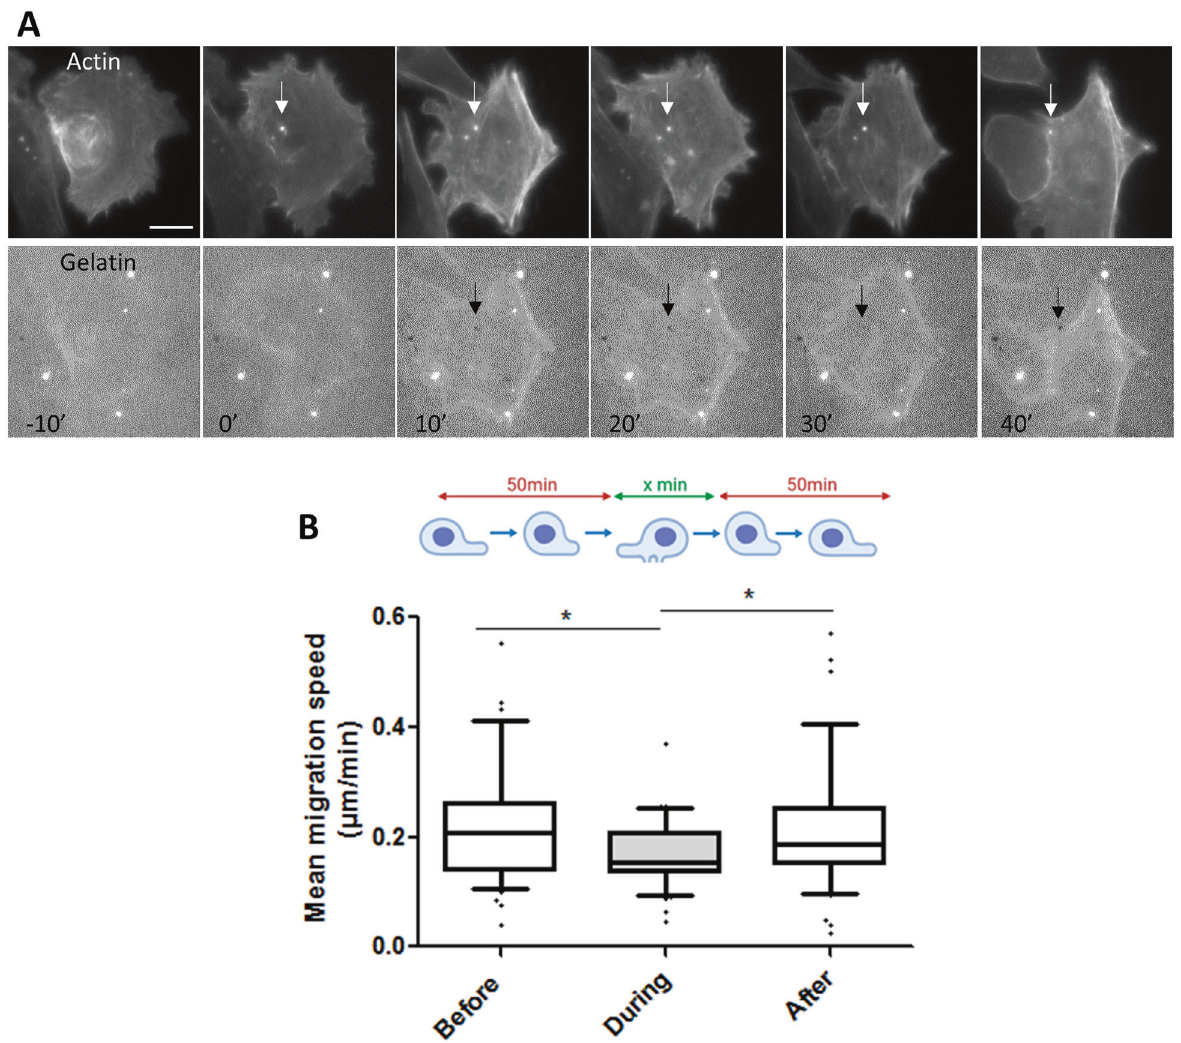
Fig. 7 Melanoma displayed deceased migration during invadopodia activity. A Dual time-lapse images of LifeAct-mCardinal and FITC- Gelatin were taken every 10 min for 24 h; representative images are shown every 10 min. Note the presence of actin spot (t = 0; white arrow) before the degradation activity ( t = 10; black arrow) Scale bar: 10 µm. B Box chart represent the mean migration speed of cells and whiskers the 10 – 90 percentile ( n = 45, from 3 independent experiments) before and during invadopodia activity. * P < 0.05; unpaired t test compared to control